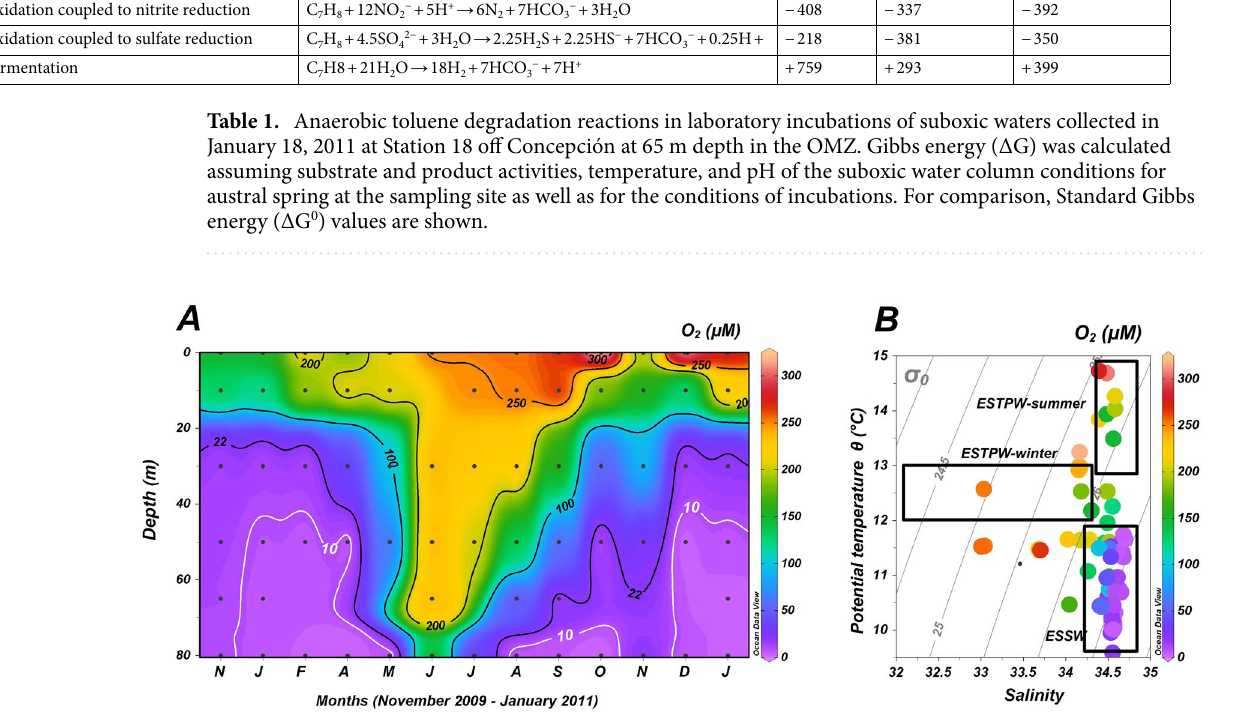
Figure 4. ( A ) Dissolved oxygen time-series data from November 2009 throughout January 2011. The white line represents the 10 µM O 2 isoline. Black dots represent sampling points. ( B ) Potential temperature ( ϴ )/salinity diagram from depth profiles taken at Station 18, off Concepción. Data points are color-coded (side color bar) for oxygen concentrations. Rectangles indicate temperature and salinity ranges for Equatorial Subsurface Water (ESSW) and Eastern South Pacific Transition Water (ESPTW) in austral winter and summer. Grey dotted lines represent isopycnals as sigma-t (σ 0 ).